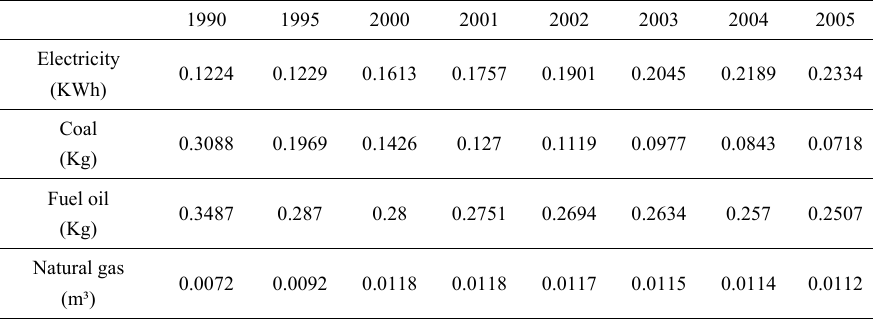
Table 1: The Energy Consume of Pronuncing 1kg